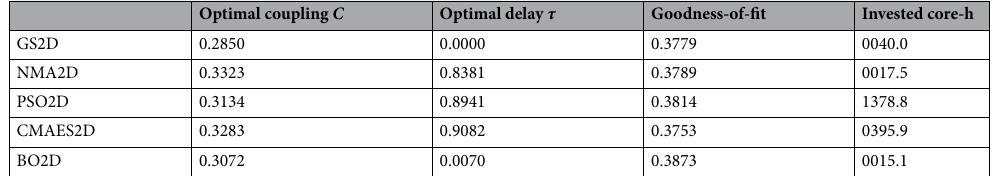
Table 1. Optimal parameter points, goodness-of-fit and the used computation time for the examples presented in Fig. 1. The indicated parameter values (coupling and delay) and the goodness-of-fit pertain to the best solution (highest goodness-of-fit) found across all 15 algorithm runs for the four optimization methods (NMA2D, PSO2D, CMEAES2D, BO2D). For the grid search in 2Dim (GS2D), the best parameter constellation obtained from a single parameter space scan is shown. The invested core-hours (core-h) for GS2D and the optimization methods represent the required resources for one thorough scan and all 15 runs in total,